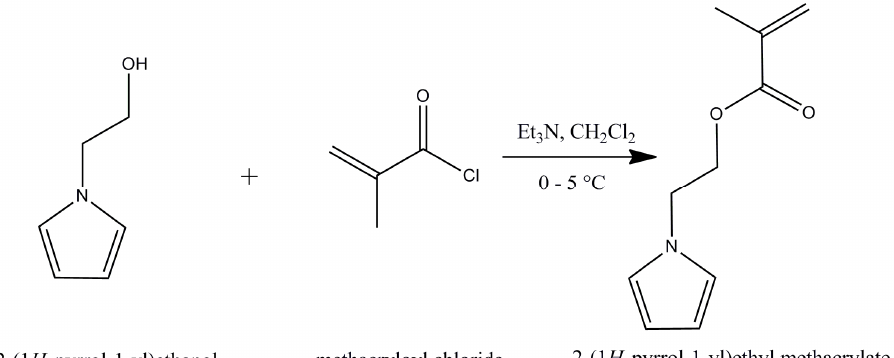
Figure 8. 1 HNMR spectrum of the 2 ‐ (1H ‐ pyrrole ‐ 1 ‐ yl)ethyl methacrylate (PyEMA).